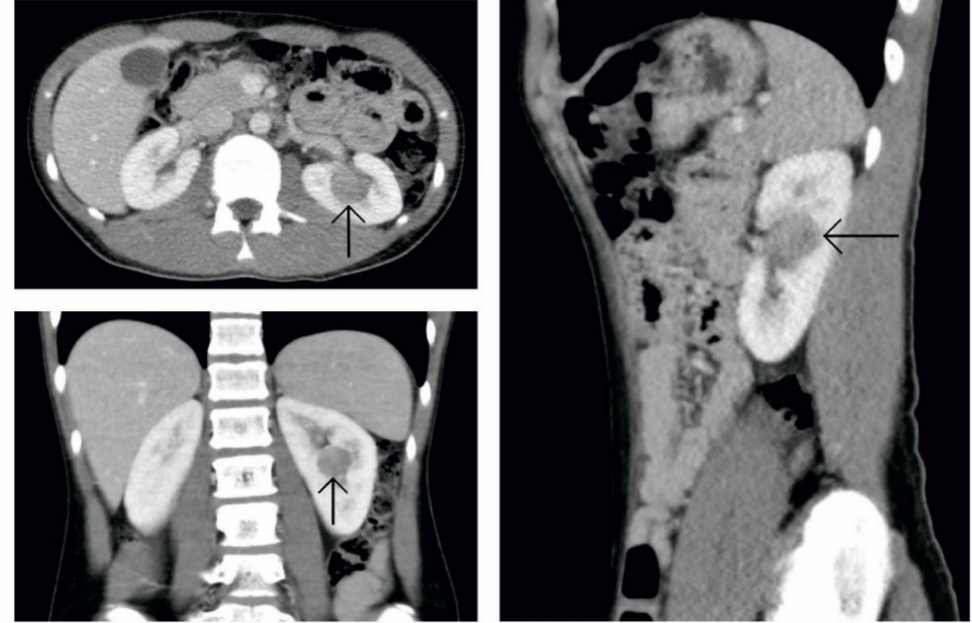
Figure 2. Computed tomography of the abdomen. Picture after administration of an intravenous contrast agent. In a central location of the left kidney is a hypodense round solid